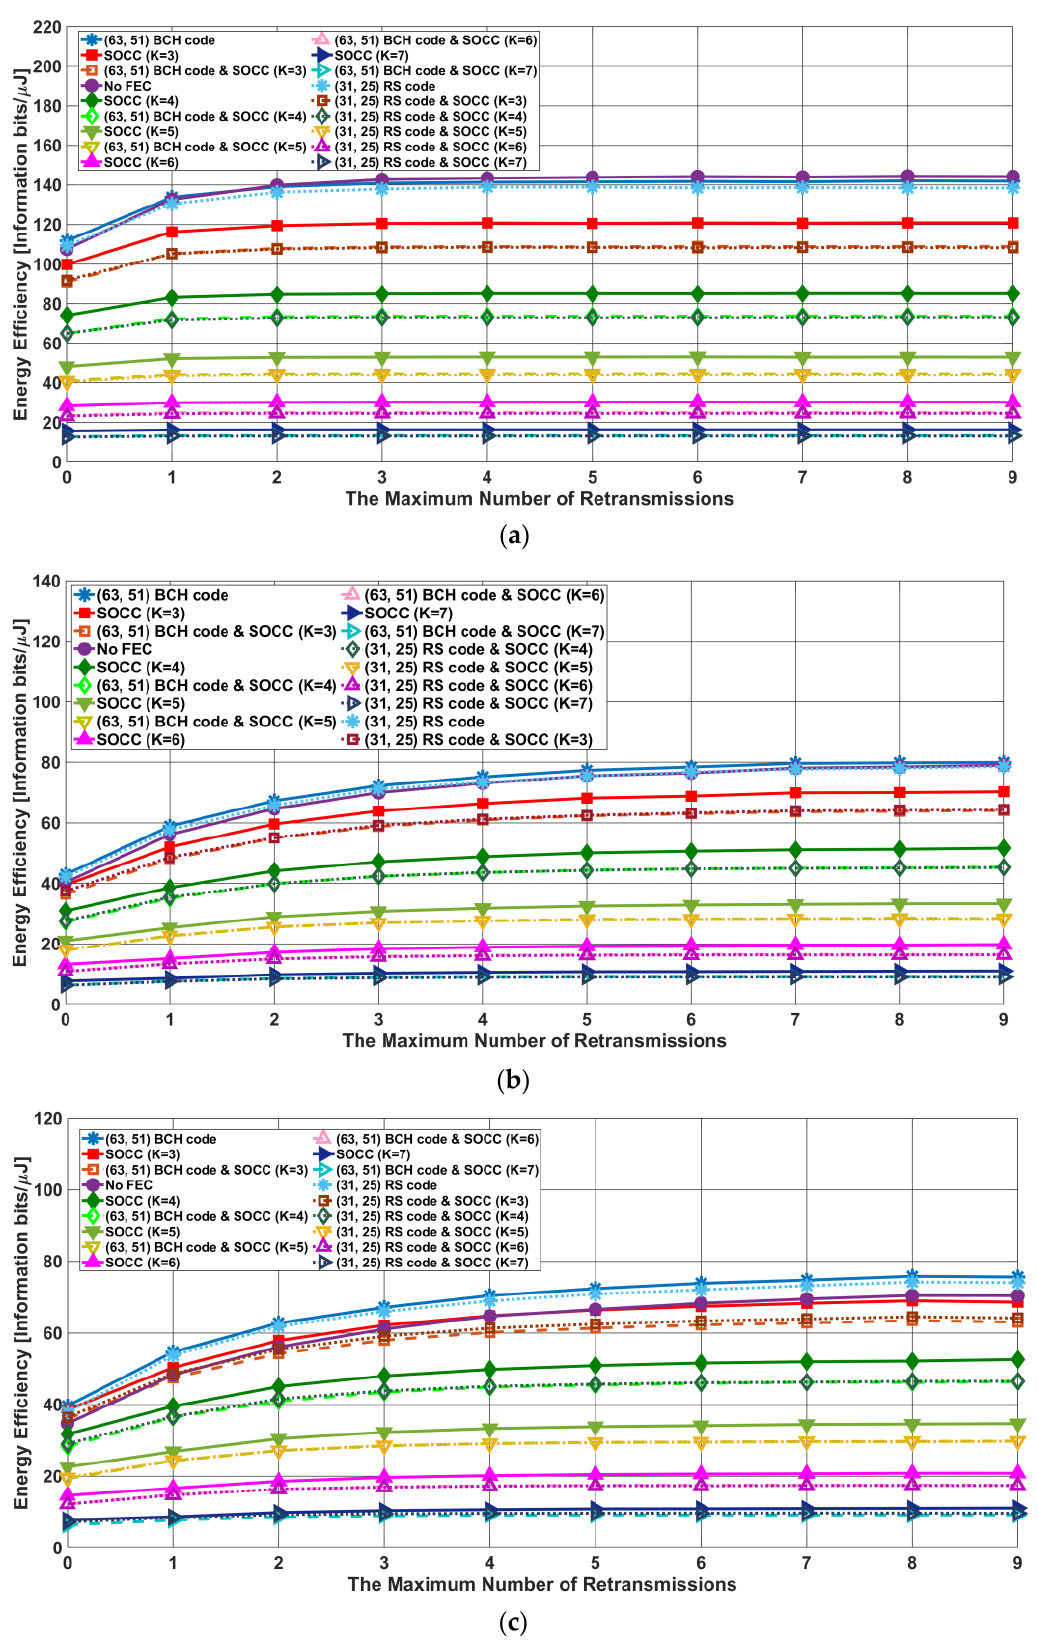
Figure 8. Energy efficiency as a function of the maximum number of retransmissions in the case of the single pulse option for each link type: ( a ) LD, ( b ) MD, and ( c ) HD.